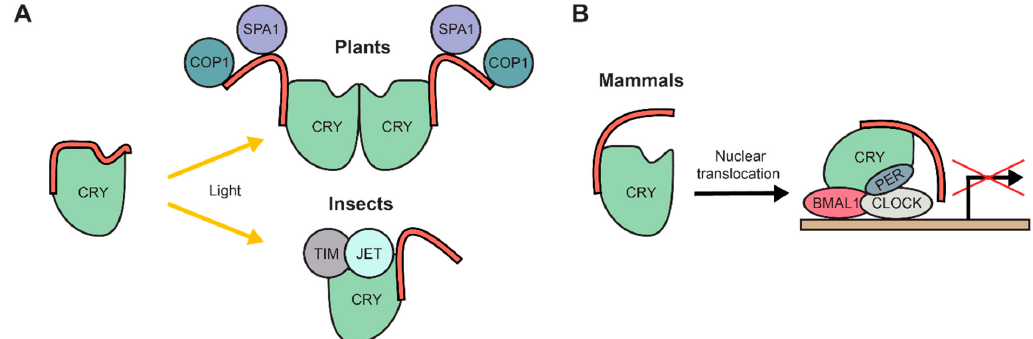
Figure 3. The intrinsically disordered C-terminal extension of cryptochromes (CRYs) has diverse functions. ( A ) Upon light perception through a photolyase homology region (PHR), the C-terminal extension (red) is released from the PHR and acquires an exposed conformation. In plants, the C-terminal extension directly binds to partner proteins, e.g. COP1 and SPA1. In insects it is not involved in binding to proteins, instead the PHR binds to partner proteins, e.g. TIM and JET. ( B ) In mammals, the C-terminal extension is responsible for translocation of CRYs to the nucleus, where they are involved in regulating gene expression as part of the central circadian clock regulation complex together with proteins like BMAL1, CLOCK and PER.